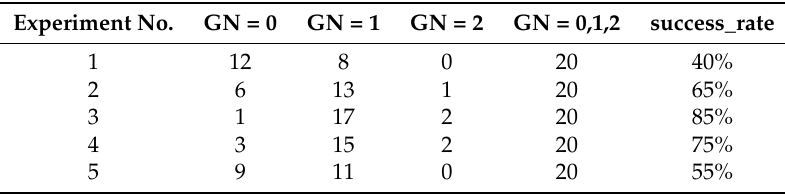
Table 5. Picking the white square towels on the table with the highest point (GN: the number of towels grasped).